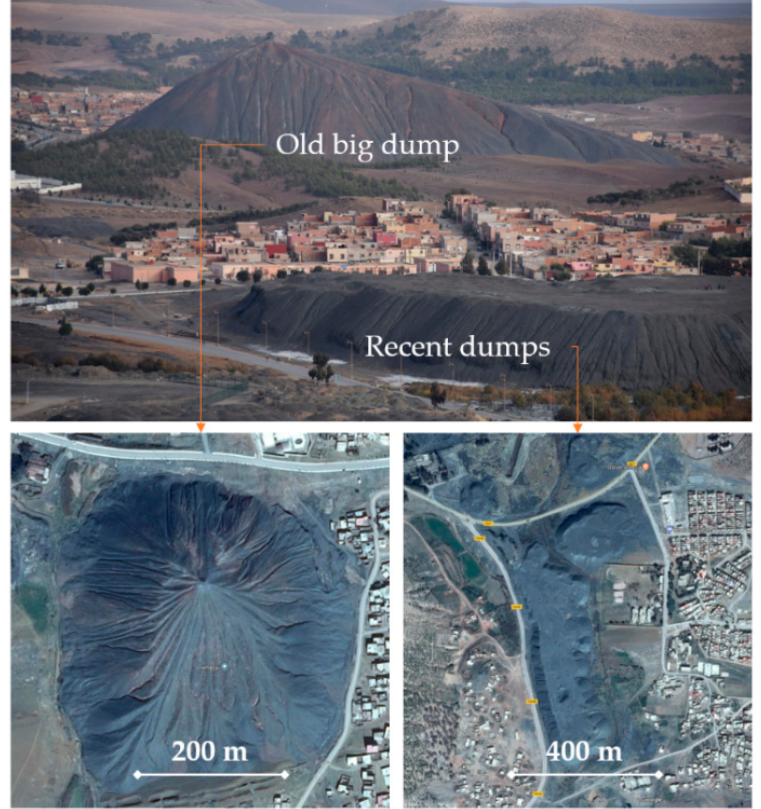
Figure 1. Old and recent coal dumps in the Jerada city.